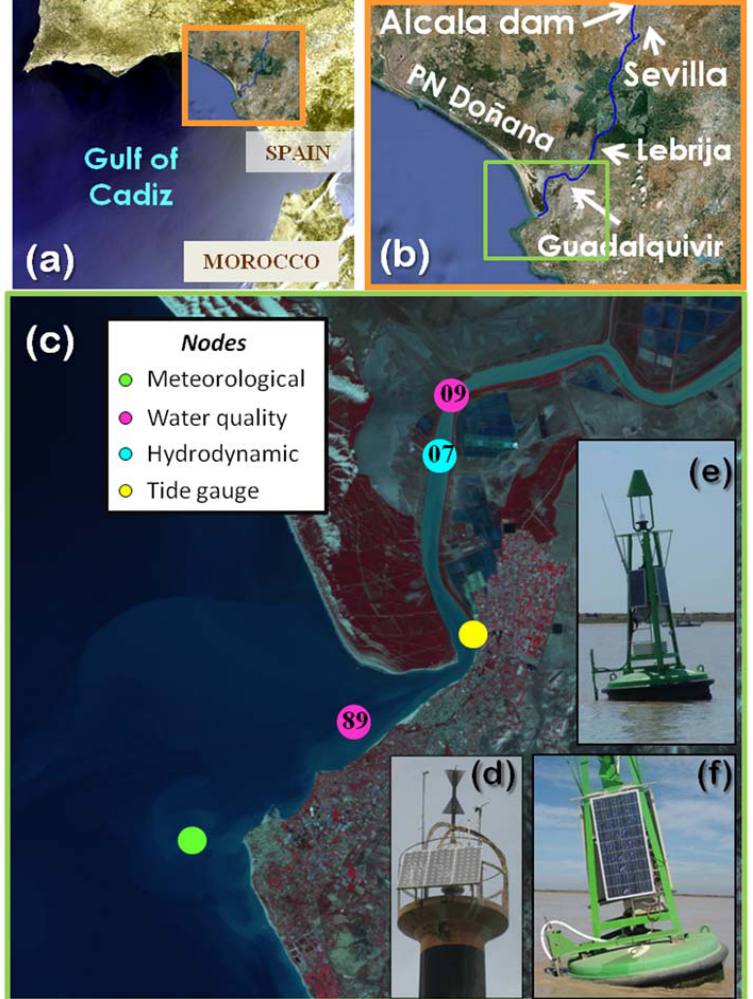
Figure 1. ( a ) Location of the Guadalquivir estuary in the SW Iberian Peninsula; ( b ) Zoom of the study area; ( c ) Locations of various stations of the RTRM (hydrodynamical, hydrological and meteorological nodes) and tide gauge station; ( d) Photograph of the Salmedina buoy (meteorological node); ( e ) Photograph of the hydrodynamical node (node 07); ( f ) Photograph of the water quality node (node